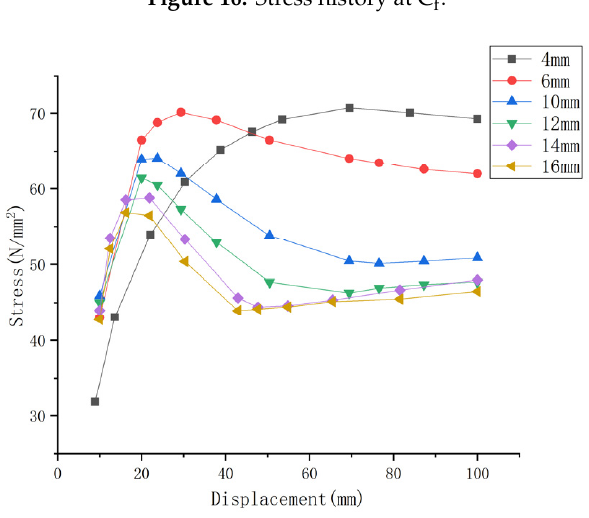
Figure 16. Stress history at C f .